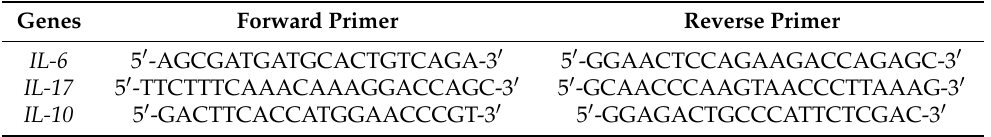
Table 1. Primer Sequences for RT-PCR.